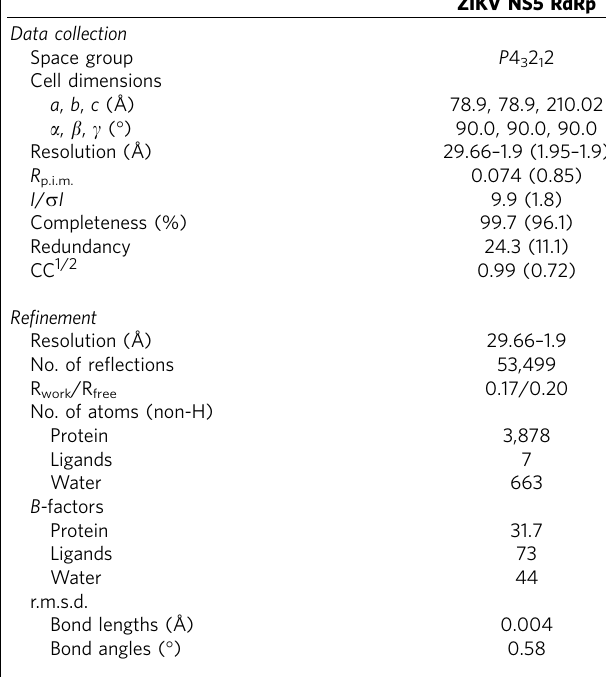
Table 1 | Data collection and refinement